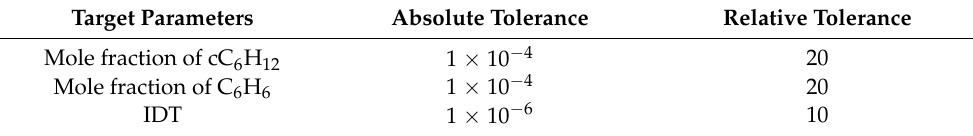
Table 1. Error setting of target